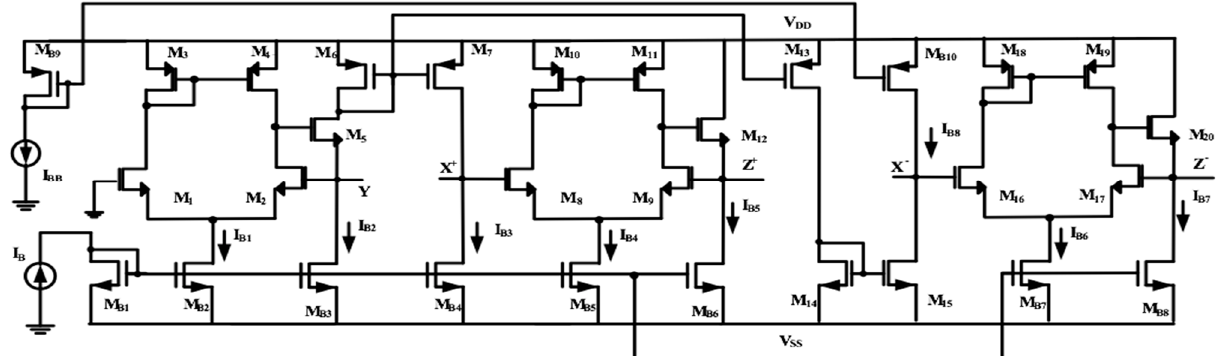
Figure 6. CMOS implementation of VCII ± .